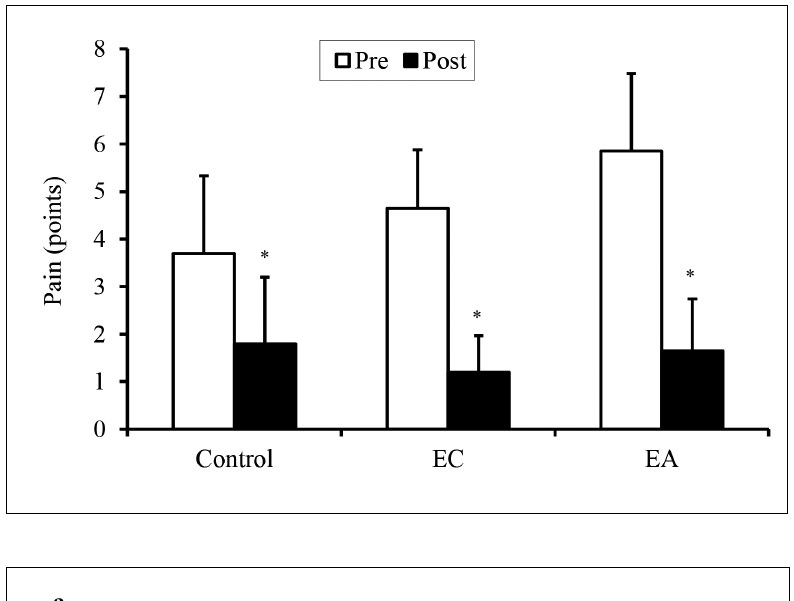
Figure 6. Mean values (coefficient of variation (CV)) of the range of motion (ROM), (a) flexion; (b) extension of Control, Experimental Chronic pain (EC) and Experimental Acute pain (EA) groups pre and post knee brace wear